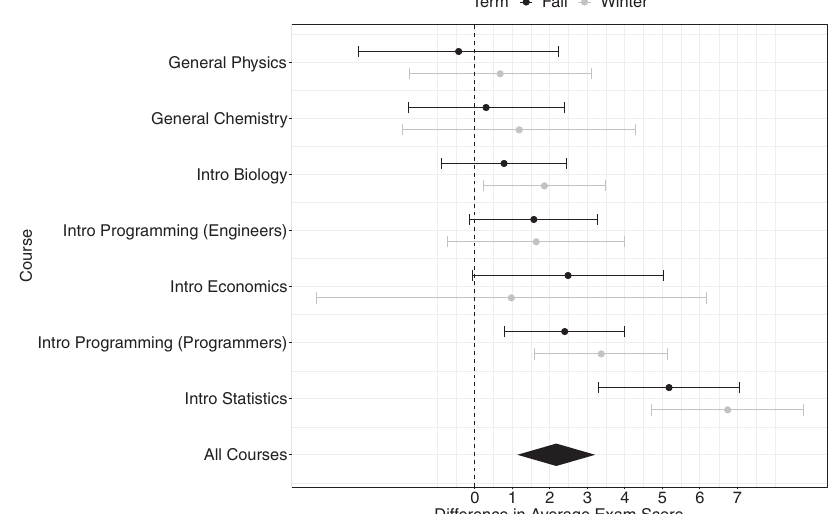
Fig. 1 Meta-analysis of the Effect of Using the Exam Playbook. Note. Forest plot summarizing a meta-analysis of the effect of using the Exam Playbook on students ’ averaged exam score. Data points represent the effect size for each class in each semester, with error bars representing 95% con fi dence intervals. The diamond in the last row represents the weighted meta-analytic effect size 30 , and corresponds to a standardized effect size (Cohen ’ s d ) of